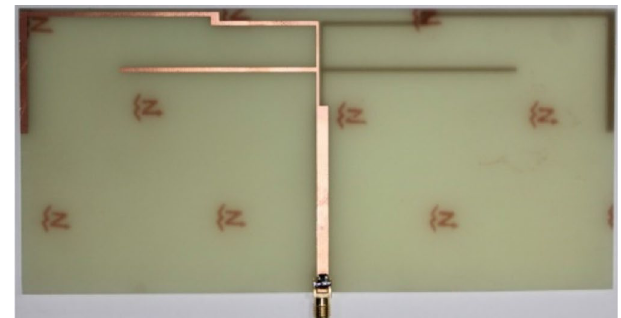
Figure 9. Photograph of the fabricated antenna.